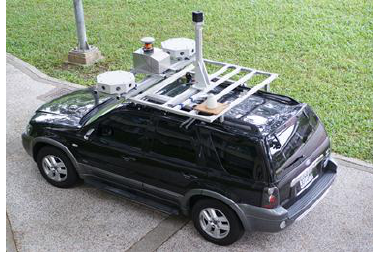
Figure 6 The proposed mobile mapping system